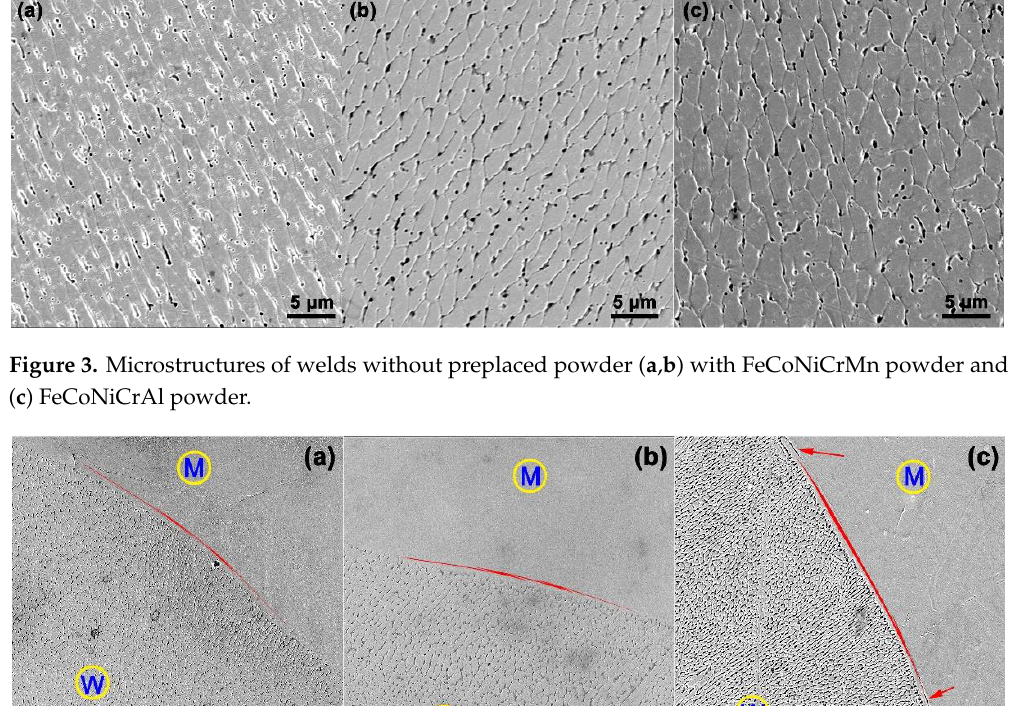
Table 1. EDS analysis (point) of welds (wt.%) compared with that of the base. Sample